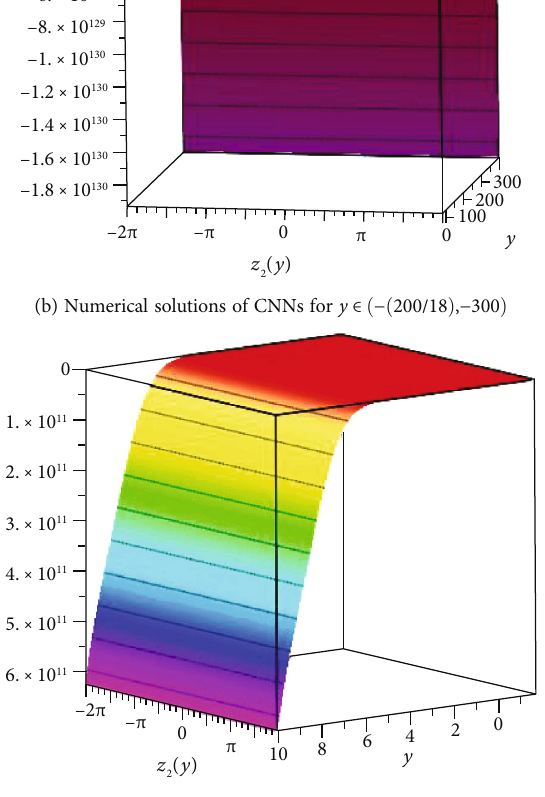
Figure 2: Graphs related to numerical solutions of CNNs (1) for di ff erent